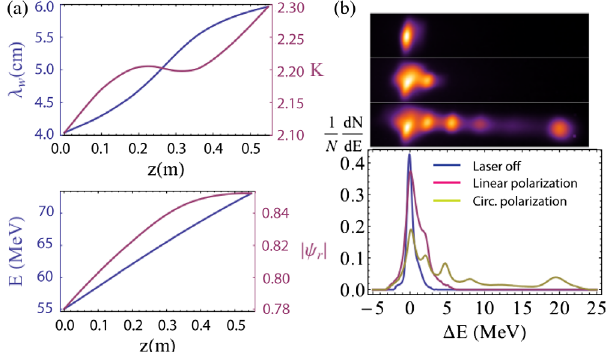
FIG. 3. (a) Rubicon IFEL period and normalized undulator parameter tapering profile (top) and corresponding resonant energy and resonant phase along the undulator(bottom). (b) Elec- tron beam spectra for no laser (blue, scaled by 1 = 2 ), linear polarization (red) and circular polarization (yellow) with seed laser energy 270